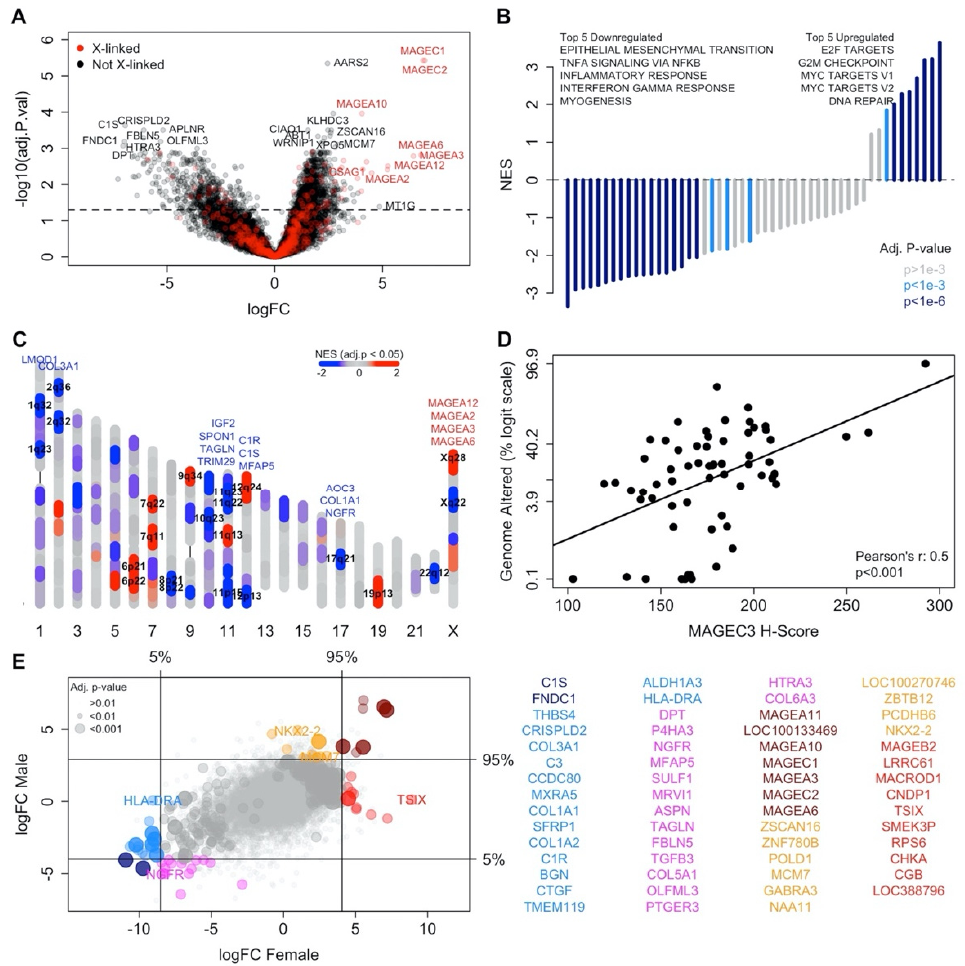
Figure 3. MAGEC3 protein DEG and GSEA analyses and association with genomic instability. ( A ) Volcano plot showing genes that are differentially expressed with continuous MAGEC3 protein ex- pression. ( B ) Gene sets that are significantly associated with continuous MAGEC3 protein expression. ( C ) Ideogram showing where significantly expressed genes are located within the genome. Genes that were individually significant are listed above their locus and loci that are GSEA significant (FDR ≤ 0.05) are labeled. ( D ) Scatterplot showing the correlation between fraction genome altered and MAGEC3 protein levels in patients with PTEN, FAT4, BRAF, PTPRT, NF1, RB1, ATM, ATRX, IDH1, and TP63 mutations. ( E ) Comparison of DEGs between male and female patients.